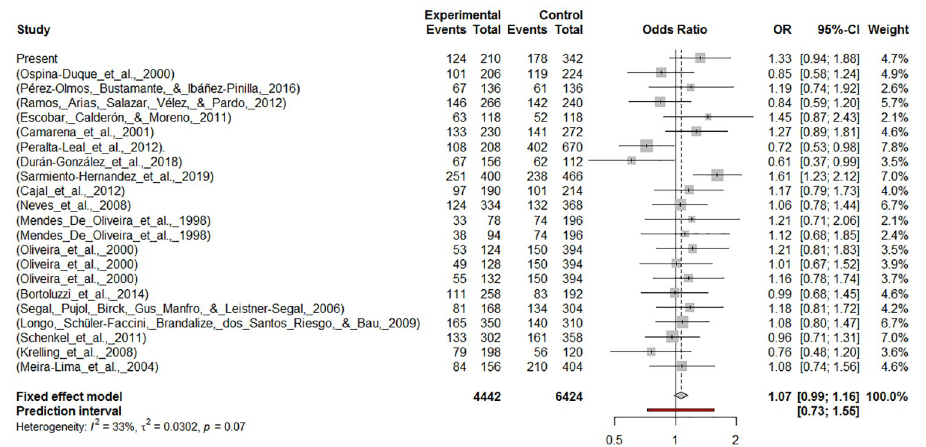
Fig 1. Meta-analysis evaluating 5-HTTLPR polymorphism in Latin American population. Forest plot for the allelic model. The trait and country for each study are found in Table 3. The forest plots for other two models are found in S2 Fig.